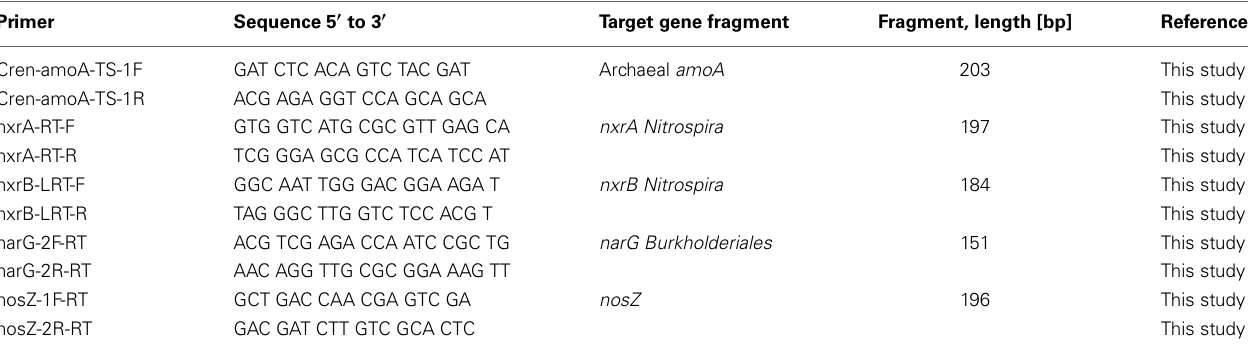
Table 2 | Primer designed for real-time PCR on functional